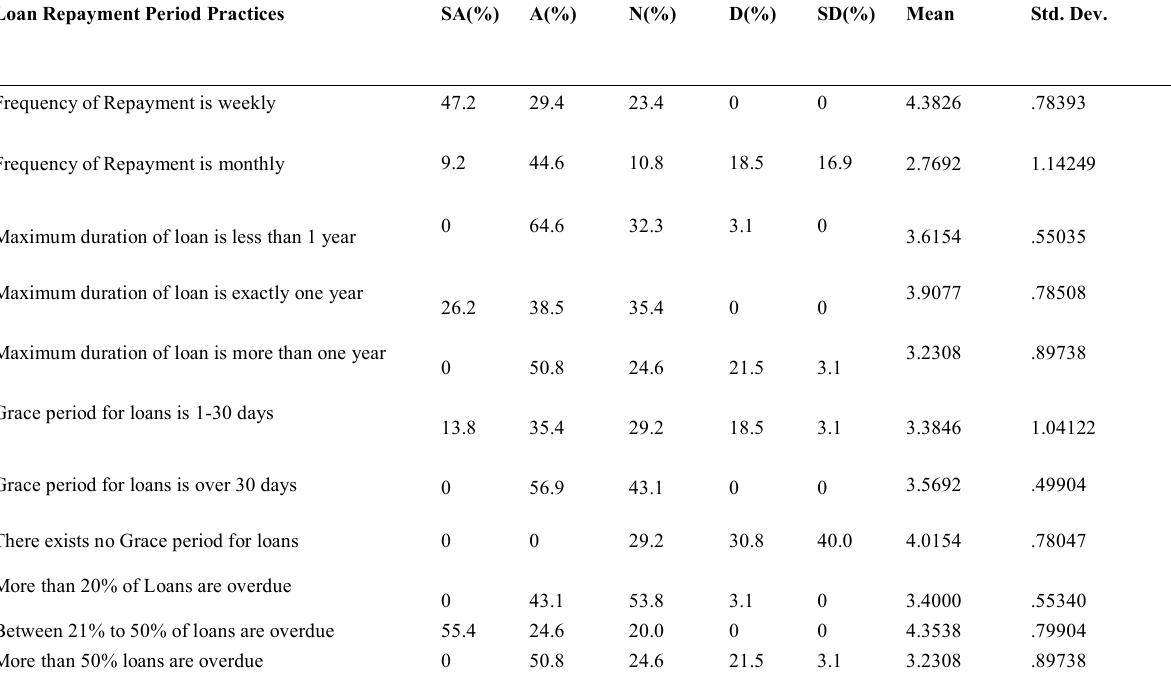
Table 6: Descriptive Statistics of Loan Repayment Period